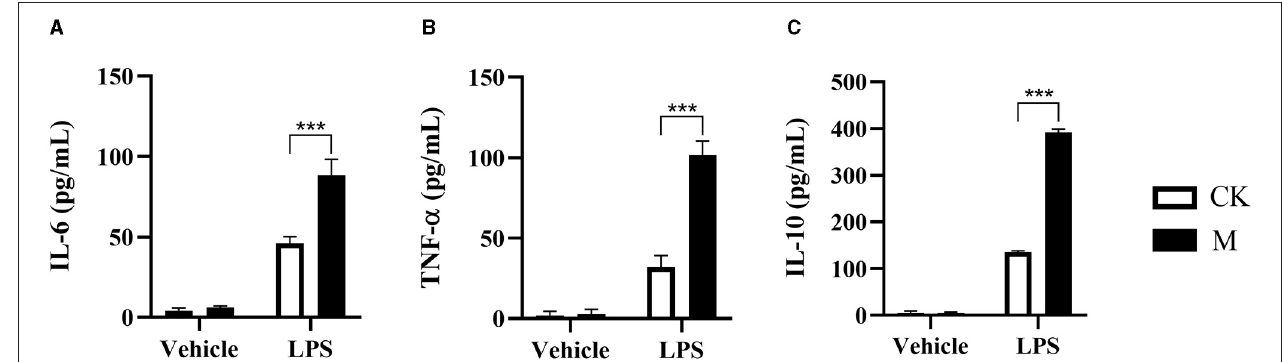
FIGURE 1 | Changes to cytokine in the splenic B cells post EgPSC infection. The CD19 + B cells were isolated from the spleens of control or EgPSC infected mice and cultured with vehicle or LPS (10 µ g/ml) for 24h. The cytokine level in the culture supernatants was detected by ELISA. (A) IL-6, (B) TNF- α , and (C) IL-10. Values are mean ± standard error of means. n = 4 mice per group. CK, control check group; M, model group. (Student’s t -test: *** P < 0.001).